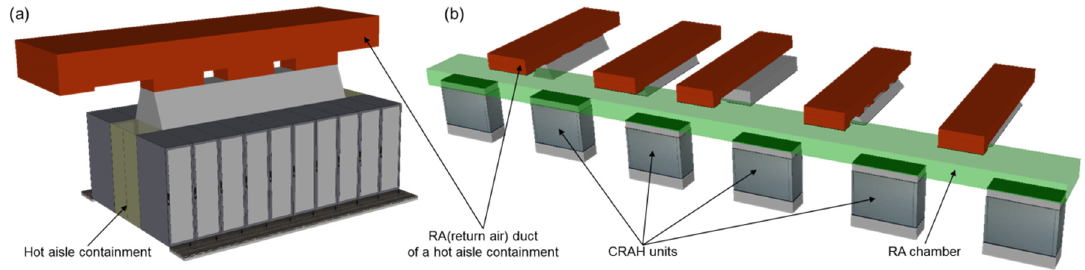
Figure 4. Hot aisle containment (HAC) model; ( a ) unit modeling of a hot aisle containment and ( b ) hot aisle containment system with RA chamber and CRAH units.